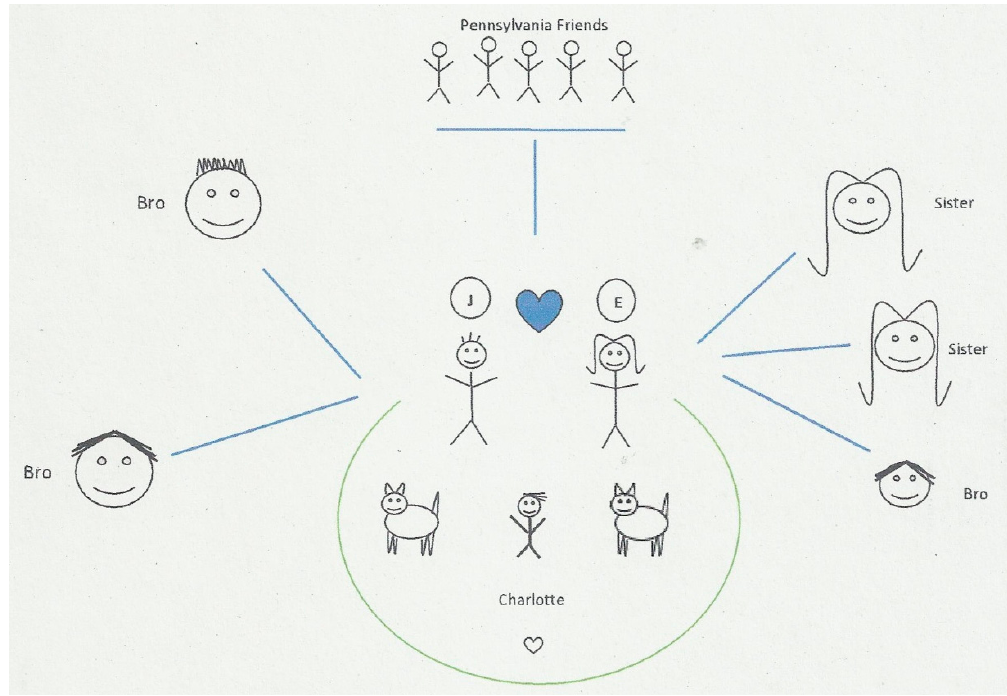
Figure 1. Ella and Jamie’s family map.